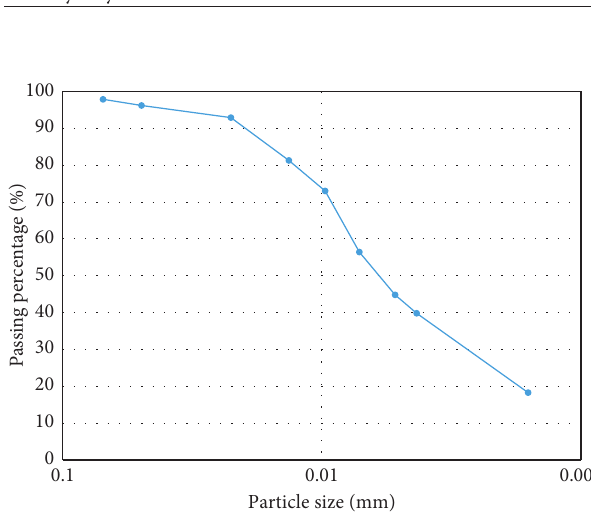
Figure 3: Grain size distribution curve of the